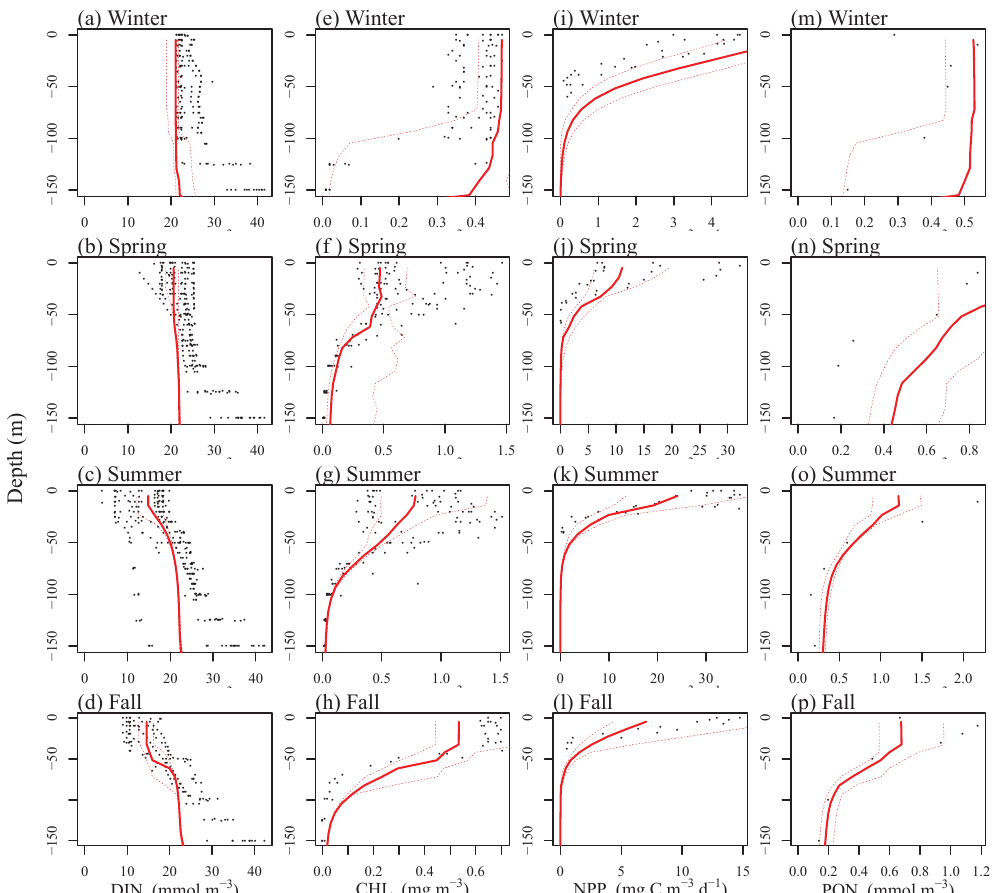
Figure 6. Model fittings to vertical profiles of (a)–(d) DIN, (e)–(h) Chl, (i)–(l) NPP, and (m)–(p) PON for four seasons at station K2. Black dots represent observational data and thick red solid lines represent the averaged seasonal values predicted by the model. Thin dashed lines represent the 95th percentiles of the seasonal